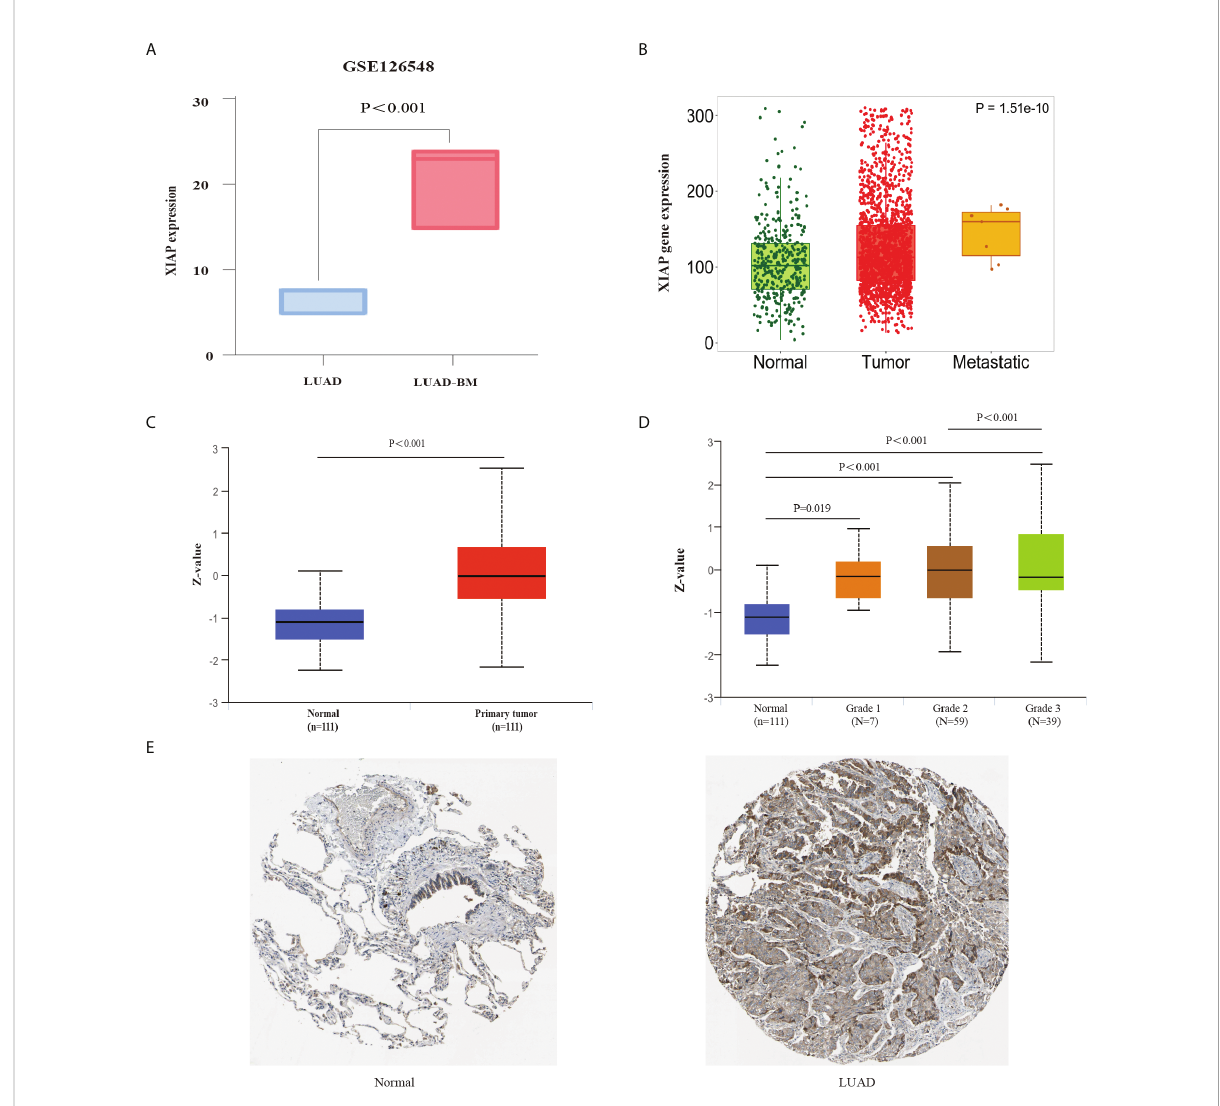
FIGURE 3 External data validation of XIAP expression in LUAD and LUAD-BM. (A) The expression of XIAP for LUAD and LUAD-BM in GSE126548. (B) The relationship of XIAP and LUAD metastasis in TNM plot. (C, D) upregulated expression of XIAP protein in LUAD tissue was associated with tumor grade. (E) The Immunohistochemistry showed that XIAP protein was increased in LUAD tumor than normal tissue in HPA database. P < 0.05 indicated signi fi cant